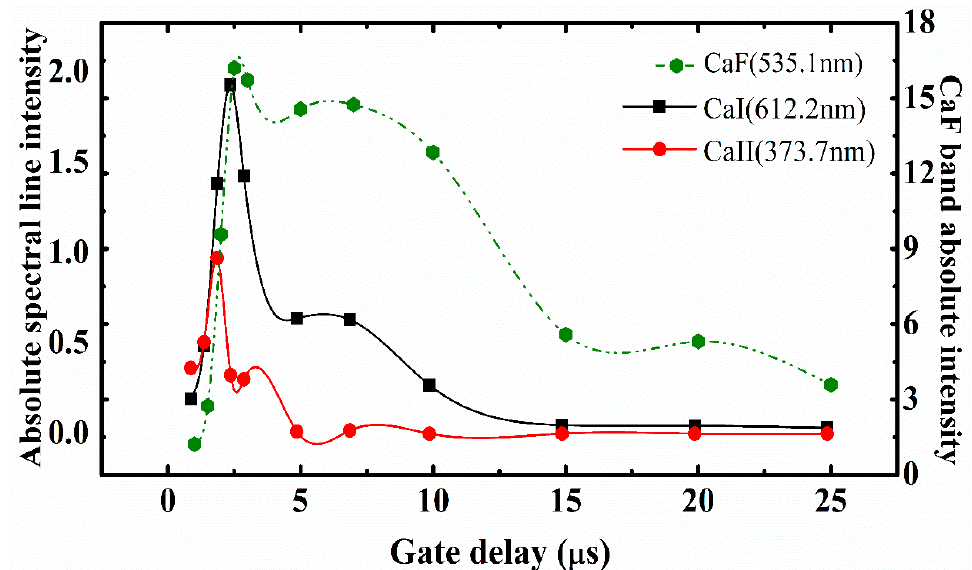
Figure 6. Temporal evolution of atomic, ionic lines of Ca and the CaF molecular band at 612.2 nm, 373.7 nm, and 535.1 nm, respectively.